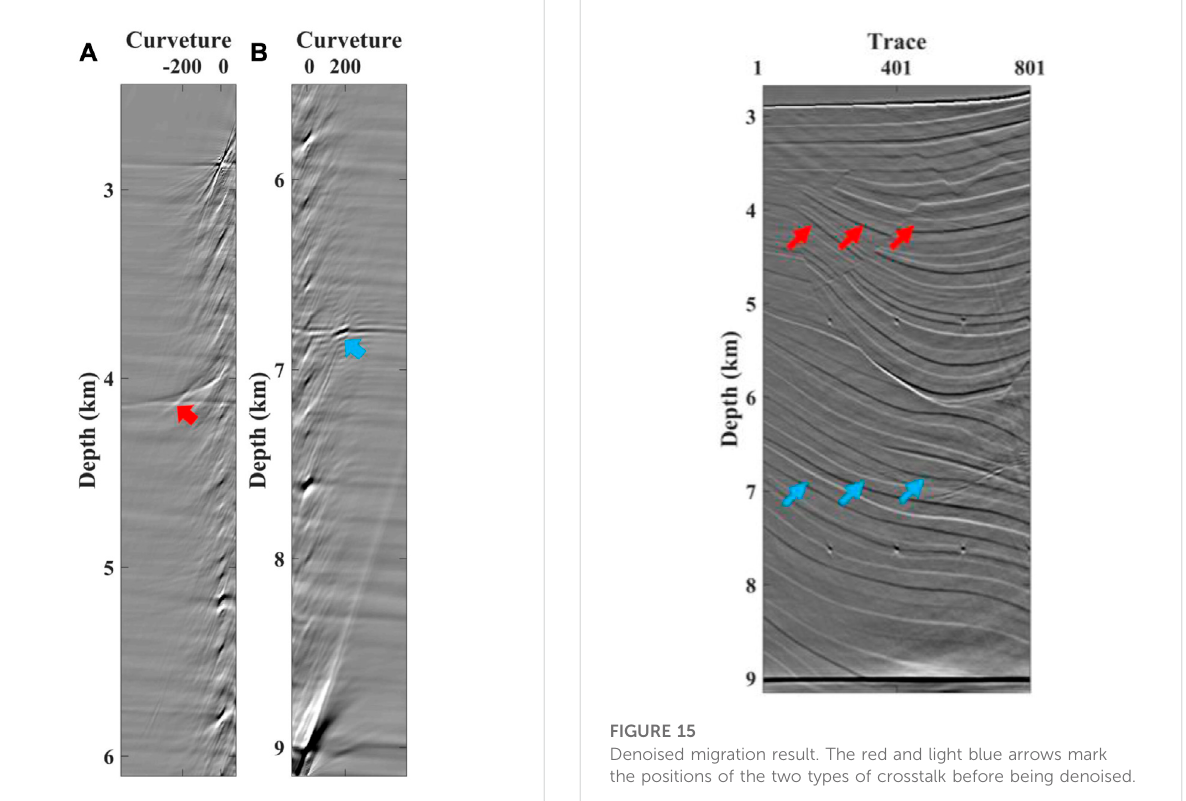
FIGURE 14 Results in radon domain after radon transform with two kernel functions. (A) The Radon transform using the RMO equation of anti- causal crosstalk as the kernel function, (B) the Radon transform using the RMO equation of causal crosstalk as the kernel function. The red arrows and light blue arrows mark the locations where the anti- causal crosstalk and the causal crosstalk are located, respectively.